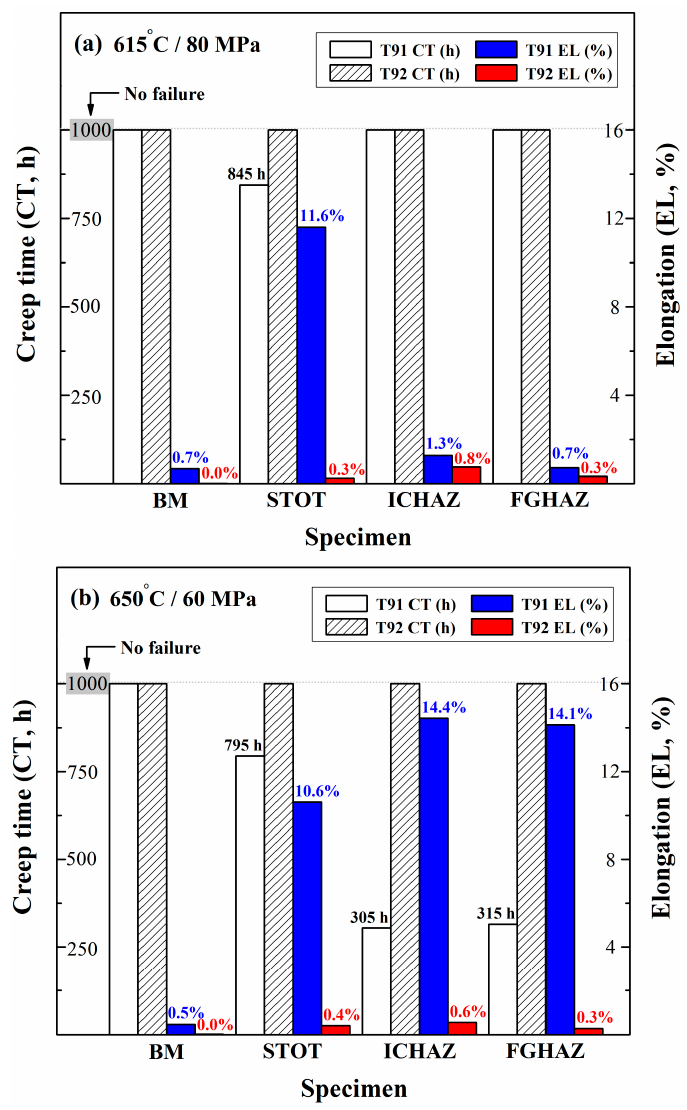
Figure 8. Creep tests of T91 and T92 specimens after PWHT at: ( a ) 615 °C/80 MPa; and ( b ) 650 °C/60 MPa. ( b ) 650 ◦ C/60